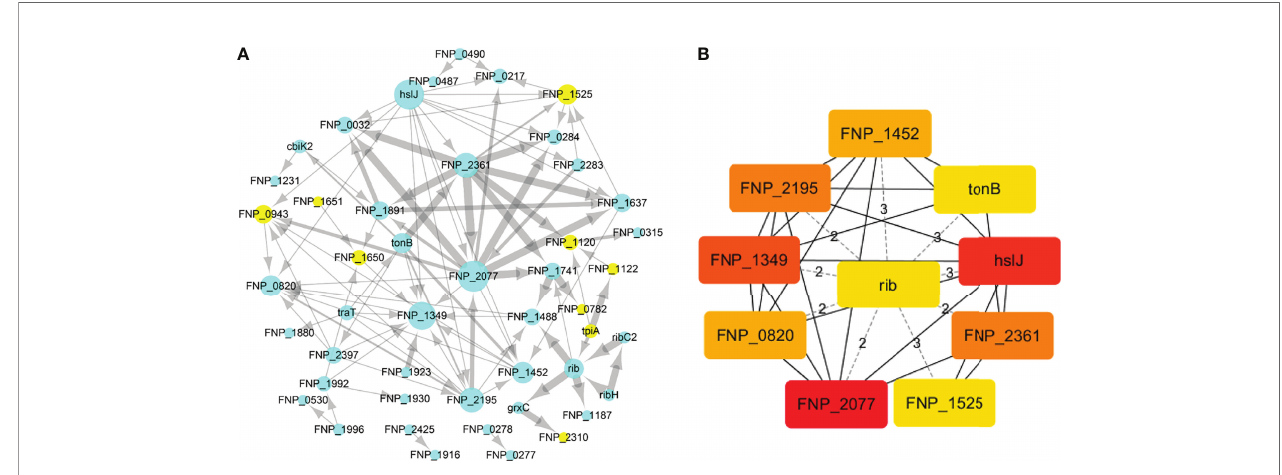
FIGURE 4 | The PPI network construction and hub proteins analysis of 71 proteins. (A) The PPI network, mint green nodes represent the no human homology proteins, while yellow nodes represent human homology proteins, the node size indicates the node degree. (B) Top ten hub proteins in PPI network, the hub proteins were selected by the cytoHubba plug − in, according to node degree ≥ 10, top-ranked nodes are shown with a color scheme from highly essential (red) to essential (green). Rib: ribo fl avin synthase; HslJ: possible heat shock protein; TonB: ligand gated channel protein TonB; FNP_2077 and FNP_2361: AT family autotransporter; FNP_1349: hypothetical protein; FNP_2195: hypothetical protein; FNP_1452: iron (Fe3+) ABC superfamily ATP binding cassette transporter binding protein; FNP_1525: hypothetical protein FNP_1525; FNP_0820: possible outer membrane protein